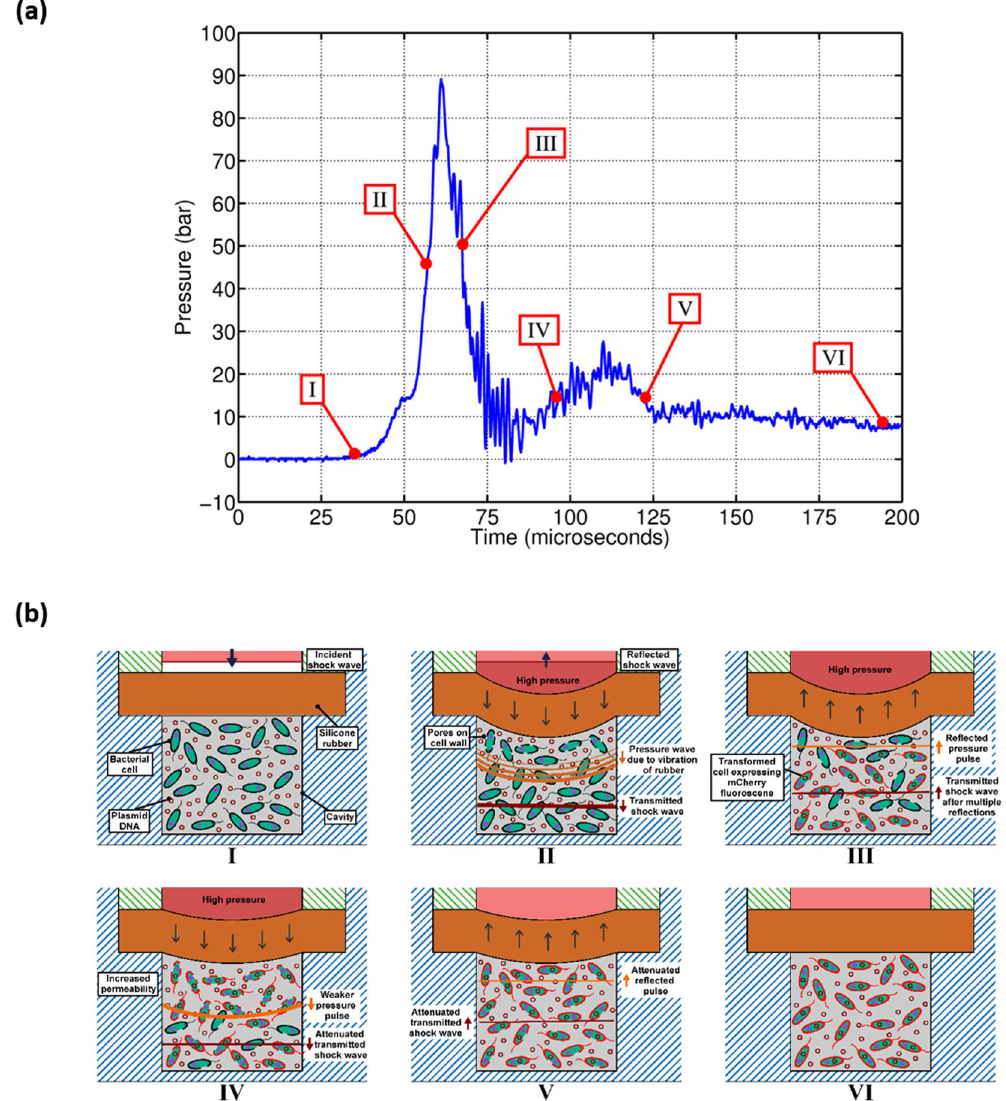
Figure 6. Proposed Mechanism of enhanced bacterial transformation. ( a ) Pressure signal indicating the location of the stages shown in the schematic diagram (Only E.coli has been considered) ( b ) Schematic diagram showing the different stages during the bacterial transformation experiment. The pressure pulse due to the vibration of rubber membrane is indicated in orange while the transmitted shock wave is shown in